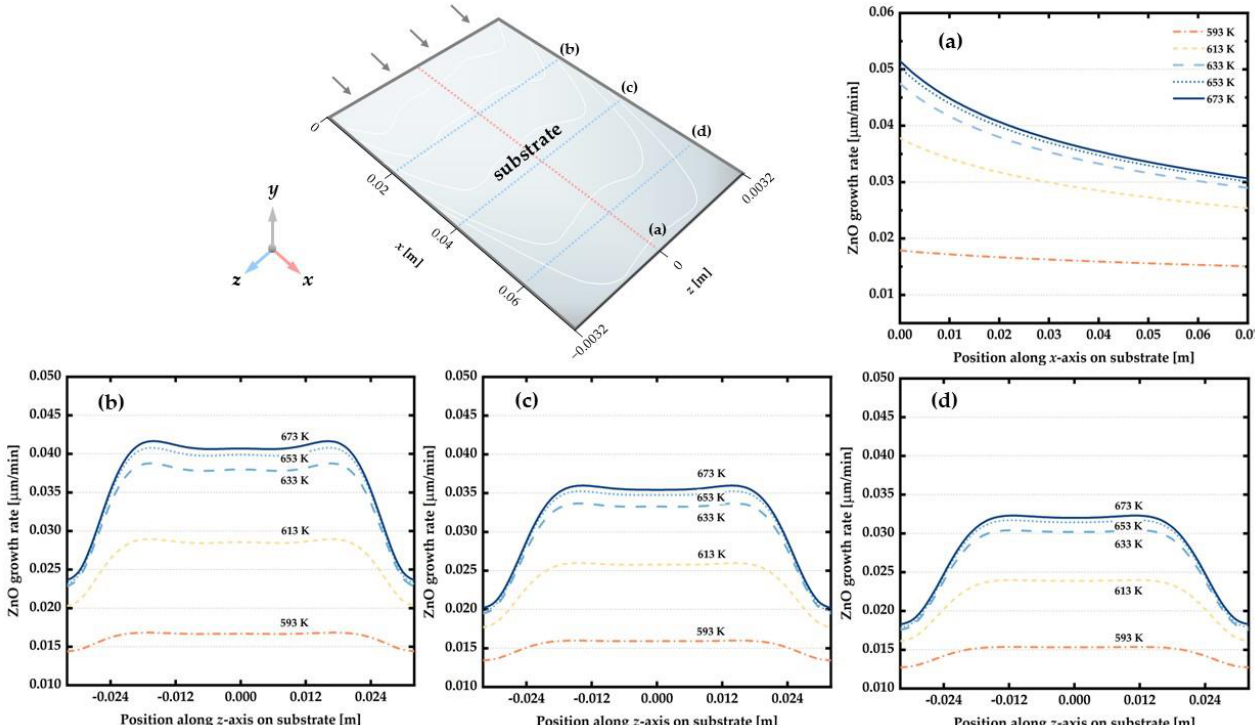
Figure 4. ZnO growth longitude distribution at position of ( a ) z = 0 m and lateral distribution at position of ( b ) x = 0.02 m; ( c ) x = 0.04 m and ( d ) x = 0.06 m on the substrate surface under the effect of the deposition temperatures from 573 K to 673 K.